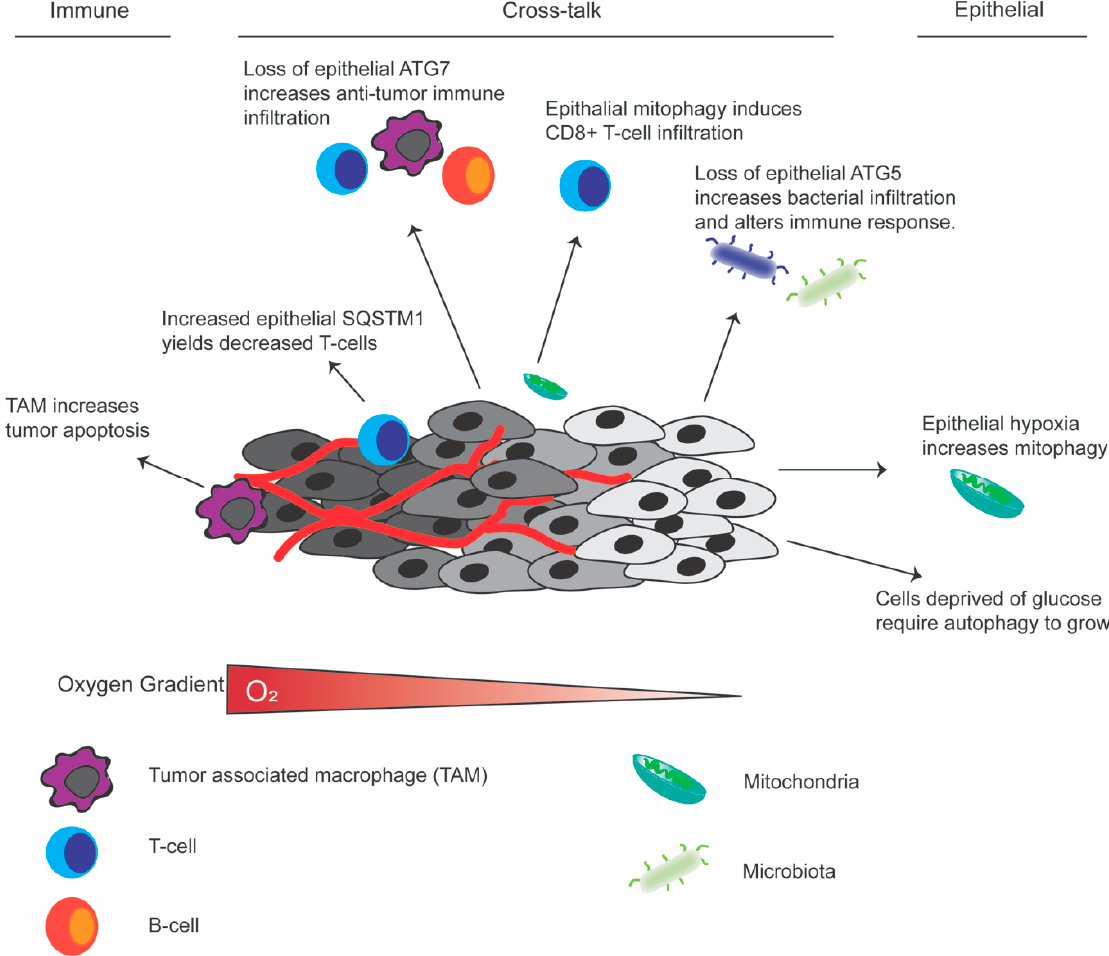
Figure 2. Schematic of the tumor microenvironment highlighting the impact of autophagy. Cell autonomous roles of autophagy in immune, epithelial or, the cross-talk between cell types in colorectal cancer.